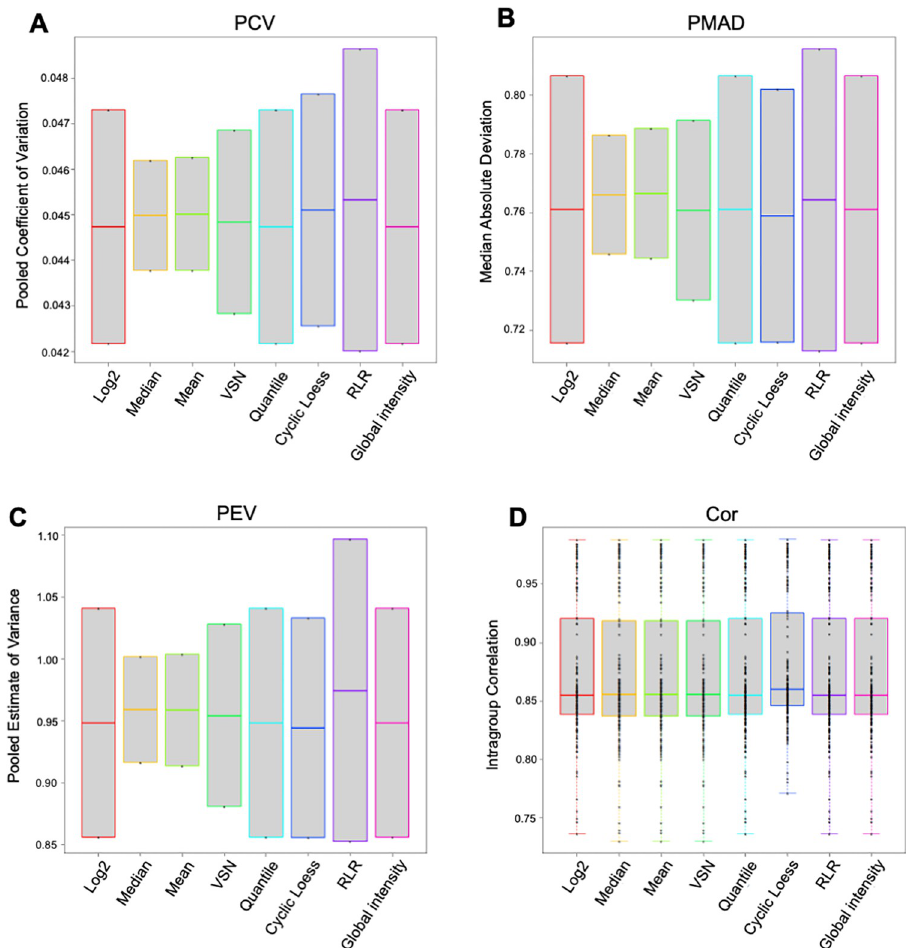
Fig 3. Quality control checks of mass spectrometry data. A-C. Pooled coefficient of variance (PCV), pooled median absolute deviation (PMAD), and pooled estimate of variance (PEV) were all small in these analyses. Small numbers here are ideal since they show low variation of the sample replicates. D. Cor graph compares the pairwise sample correlations of the treatment groups of the normalization methods. The high intragroup correlation values here are desirable since they show high correlation of the replicates within a treatment